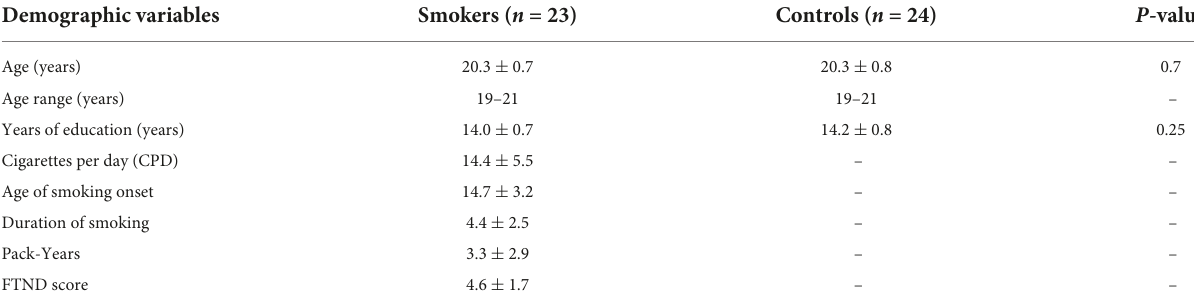
TABLE 1 Demographic characteristics of the participants.